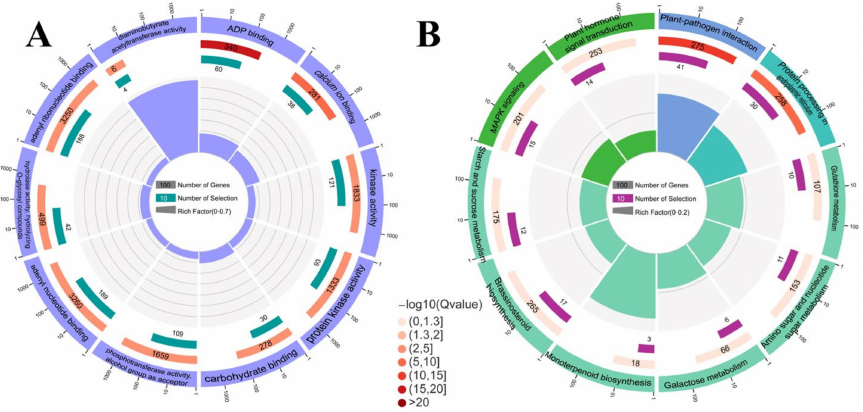
Figure 9. The up-regulated DEGs enrichment analysis utilizing GO ( A ) and KEGG ( B )